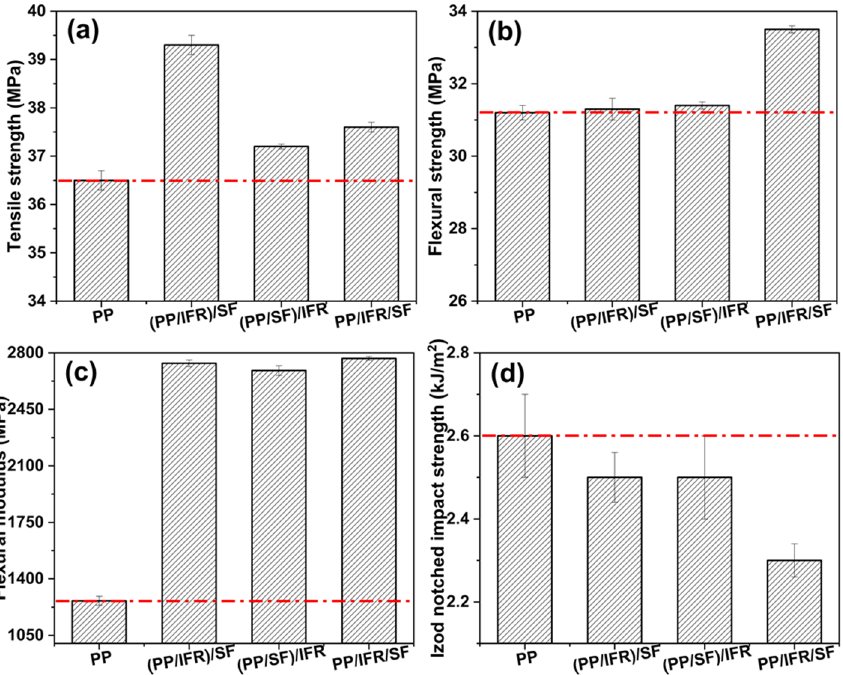
Figure 8. Mechanical properties of pure PP and PP/SF flame-retardant composites. ( a ) Tensile strength, ( b ) Flexural strength, ( c ) Flexural modulus, ( d ) Izod notched impact strength.